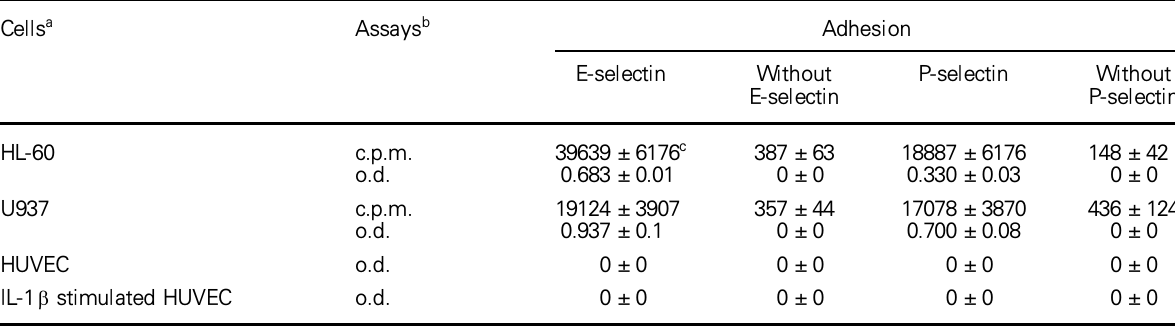
Table 2. HL-60, U937 and HUVEC cells adhesion on immobilized E- and P-selectins in static assays Cells